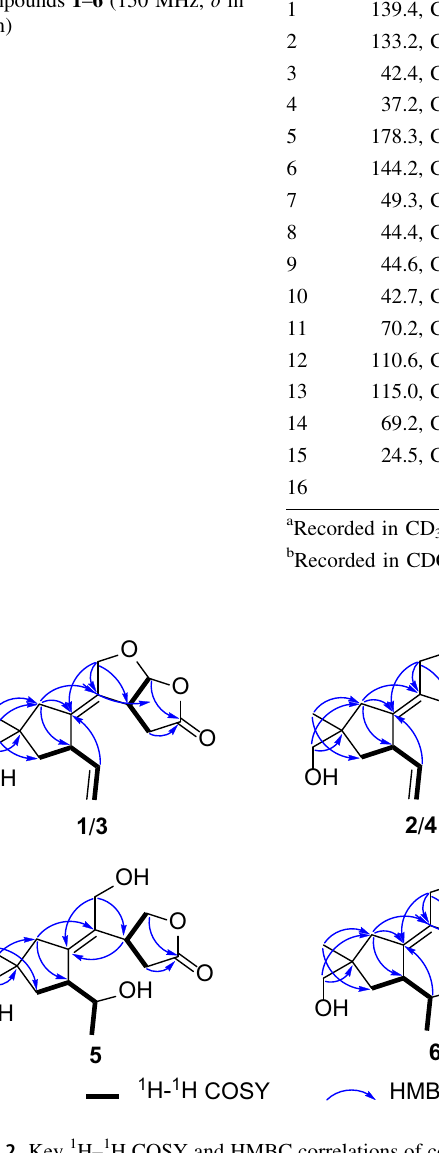
Fig. 2 Key 1 H– 1 H COSY and HMBC correlations of compounds 1 – 6